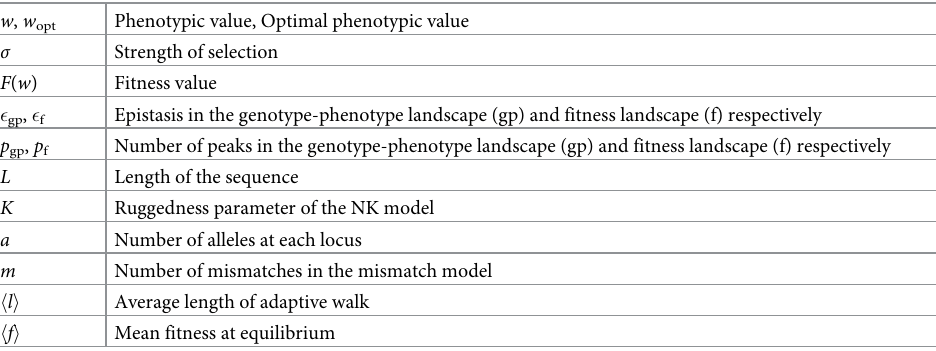
Table 1. List of